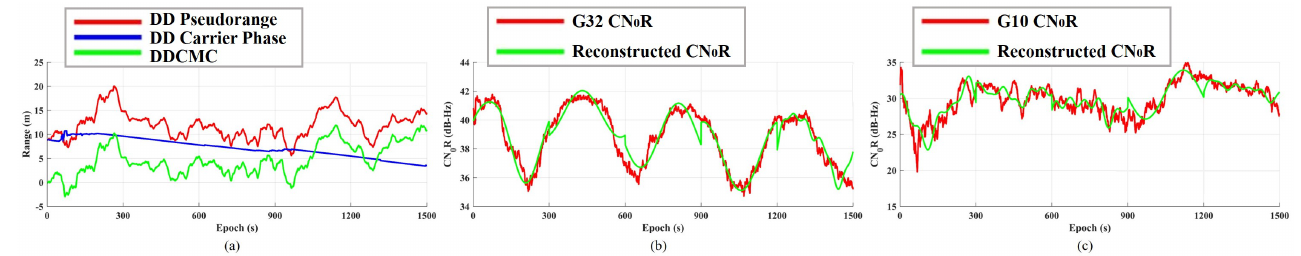
Figure 6. Results of the static multipath test. ( a ) Double-difference observations. ( b ) Reconstructed CN 0 R of G32 via MPPE. ( c ) Reconstructed CN 0 R of G10 via